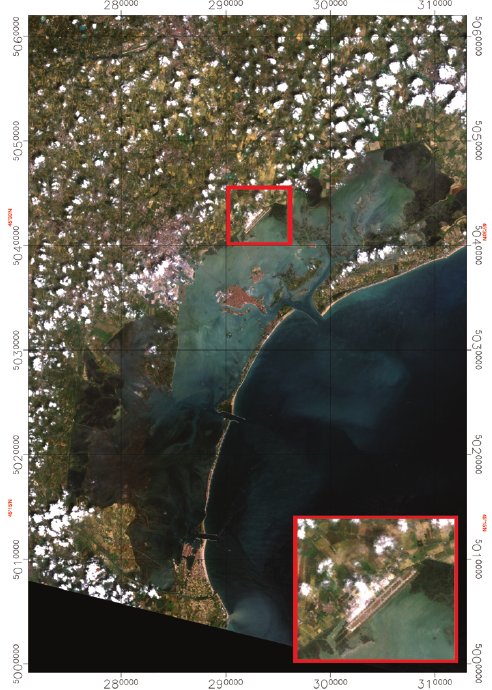
Figure 1 . The study area meets the requirements of the method: the Venice